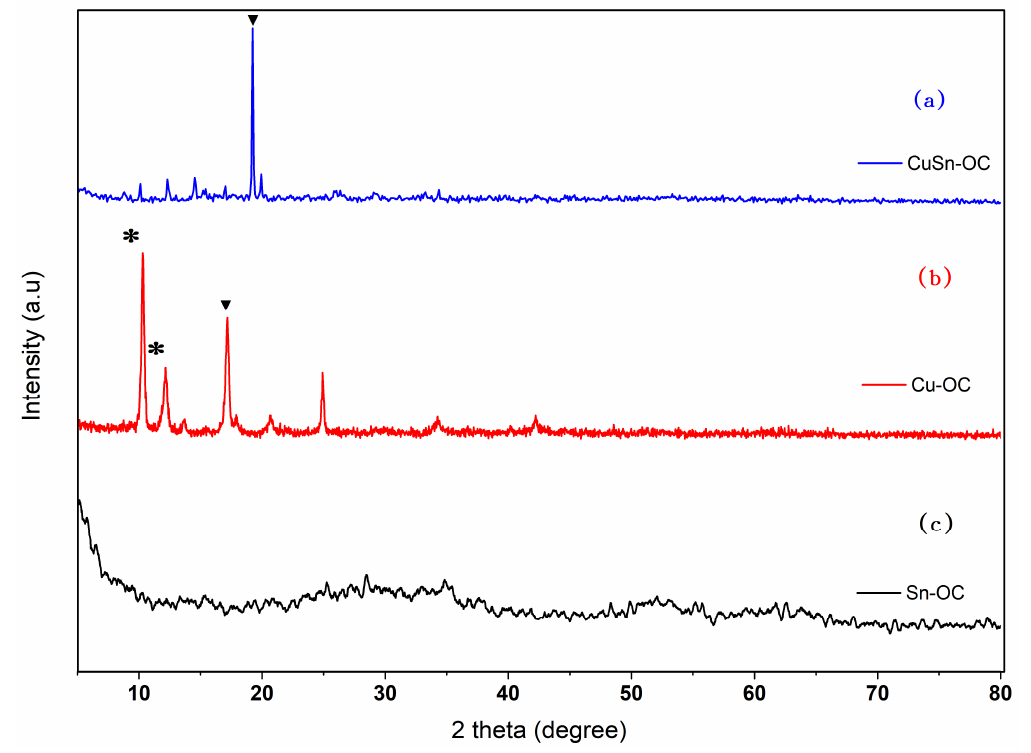
Figure 3. XRD patterns of ( a ) Cu-OC, ( b ) Sn-OC, and ( c ) CuSn-OC. According to the Debye–Scherrer formula, the average particle sizes D of the samples were given by: [25,26] D hkl = 0.9λ⁄βcosθ, whereby β is the full width at a half-maximum (FWHM) value of the XRD diffraction lines (see Figure 3a,b), λ is the wavelength whose value was 0.154056 nm, and θ is the half diffraction angle of 2θ. The crystalline sizes were determined at the highest peaks at ca. 2θ = 17.18° and 19.23°, and this is marked by ( ▼ ) in both Figure 3a,b. They were 24.34 and 62.68 nm for the Cu-OC and CuSn-OC, respectively. The microstructure of the prepared samples was further investigated by FTIR spec- troscopy as shown in Figure 4. It was found that at high-frequency regions, the nearly identical broad band located from 2000 to 3500 cm −1 for both Sn-OC and CuSn-OC samples may have been assigned to those carboxylate groups located in the big pores. Water may have been penetrating the carboxylic acid groups only in the large pores, where it proto- nated the carboxylate groups, and signals around 1700 and 1200 cm −1 , characteristic of carboxylic acid groups, appeared [27]. These results reflect the affinity of the sample con- taining the Sn cation to absorb more water during the washing process, and the result was supported by the results of the TGA in the next section. Additionally, the broadband may be explained in the base of the formation of a dimeric form of terephthalic acid, which gave rise to a broad absorption region with many sub-maxims [28] at 2500–3000 cm −1 . In the region of 2500–3500 cm −1 , we would expect also to find the C-H stretching modes of the benzyl group. The band at 578 (Figure 3c), 573 (Figure 3b), and 548 cm −1 (Figure 3a), indicate the presence of a M-O bond in the Sn-OC, Cu-OC, and CuSn-OC, respectively.